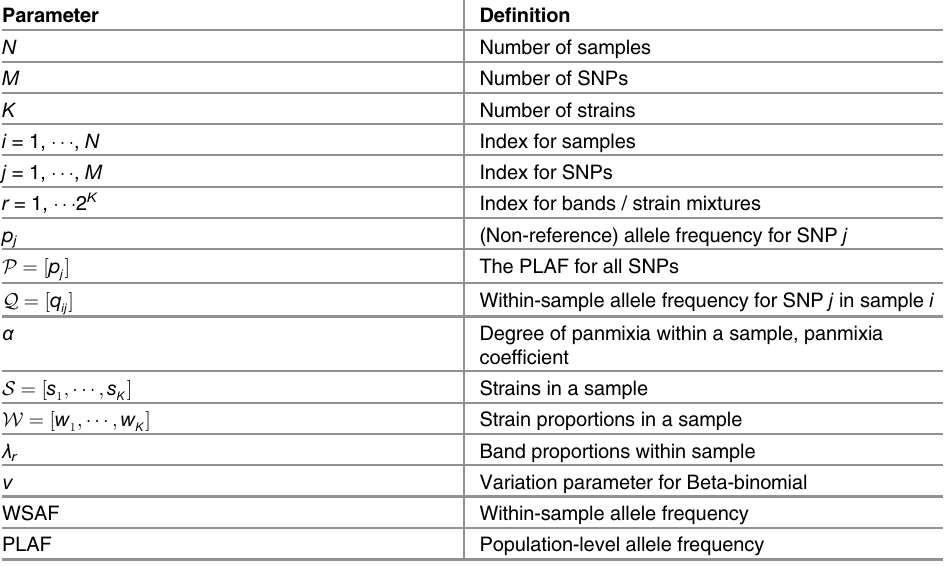
Table 1. Parameters and definitions for the model and its